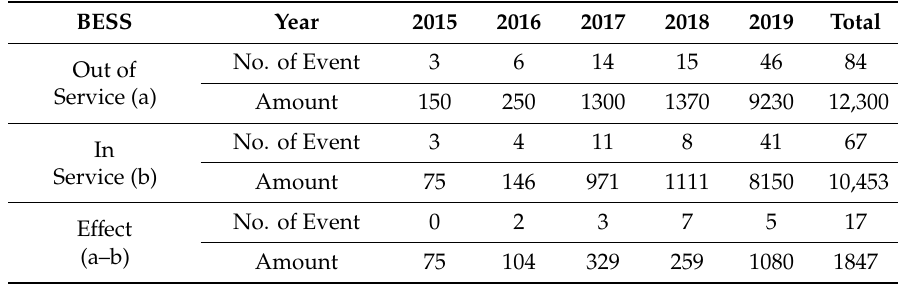
Table 4. E ff ect of mitigating renewable energy curtailment using a BESS for storage from 2015 to 2019